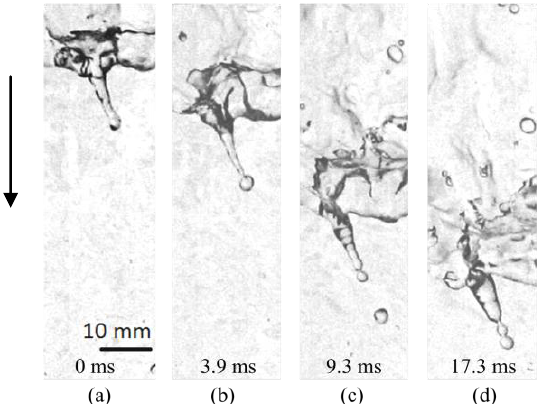
Fig. 2. Generation of droplets through the development and breakage of liquid ligaments. (a) Stretching of the ligament, t =0 ms. (b) Formation of the droplet, t =3.9 ms. (c) Separation of the first droplet and formation of the second, t =9.3 ms. (d) Formation of the third and fourth droplets, t =17.3 ms, wind speed U 10 =25 m/s, image dimensions 67.48×101.13 mm. Arrow indicates wind